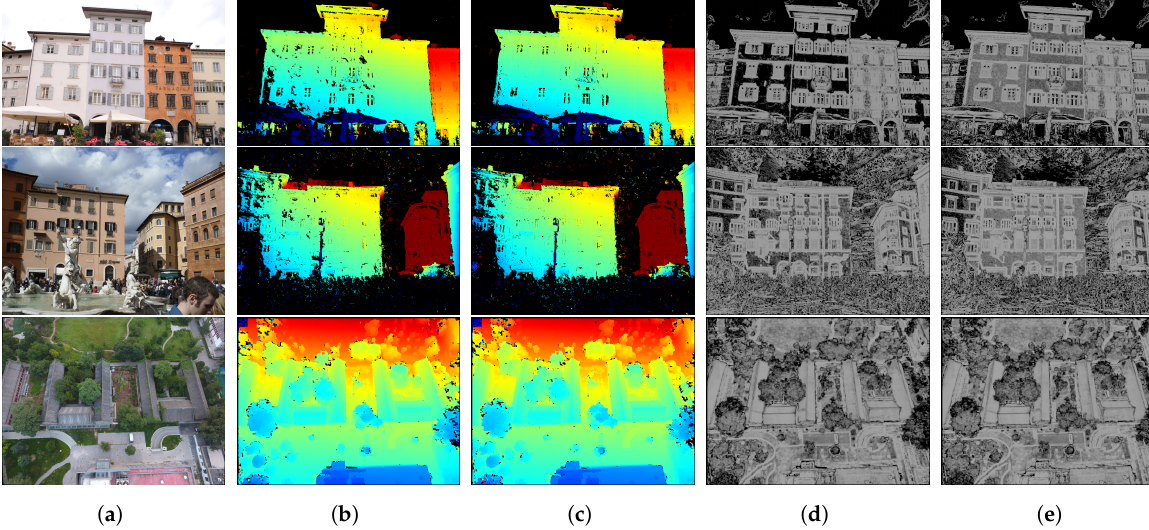
Figure 9. Qualitative depth and confidence map comparison of our method with respect to the baseline OpenMVS on our custom datasets ( PiazzaDuomo and PiazzaNavona ) and the UDD5 dataset. The proposed method improves depth estimations and achieve higher confidence scores in problematic planar areas for PiazzaDuomo and PiazzaNavona . In UDD5 , where no evident textureless areas exist, it performs like standard OpenMVS. ( a ) RGB image; ( b ) OpenMVS-depth; ( c ) proposed-depth; ( d ) OpenMVS-conf; ( e )